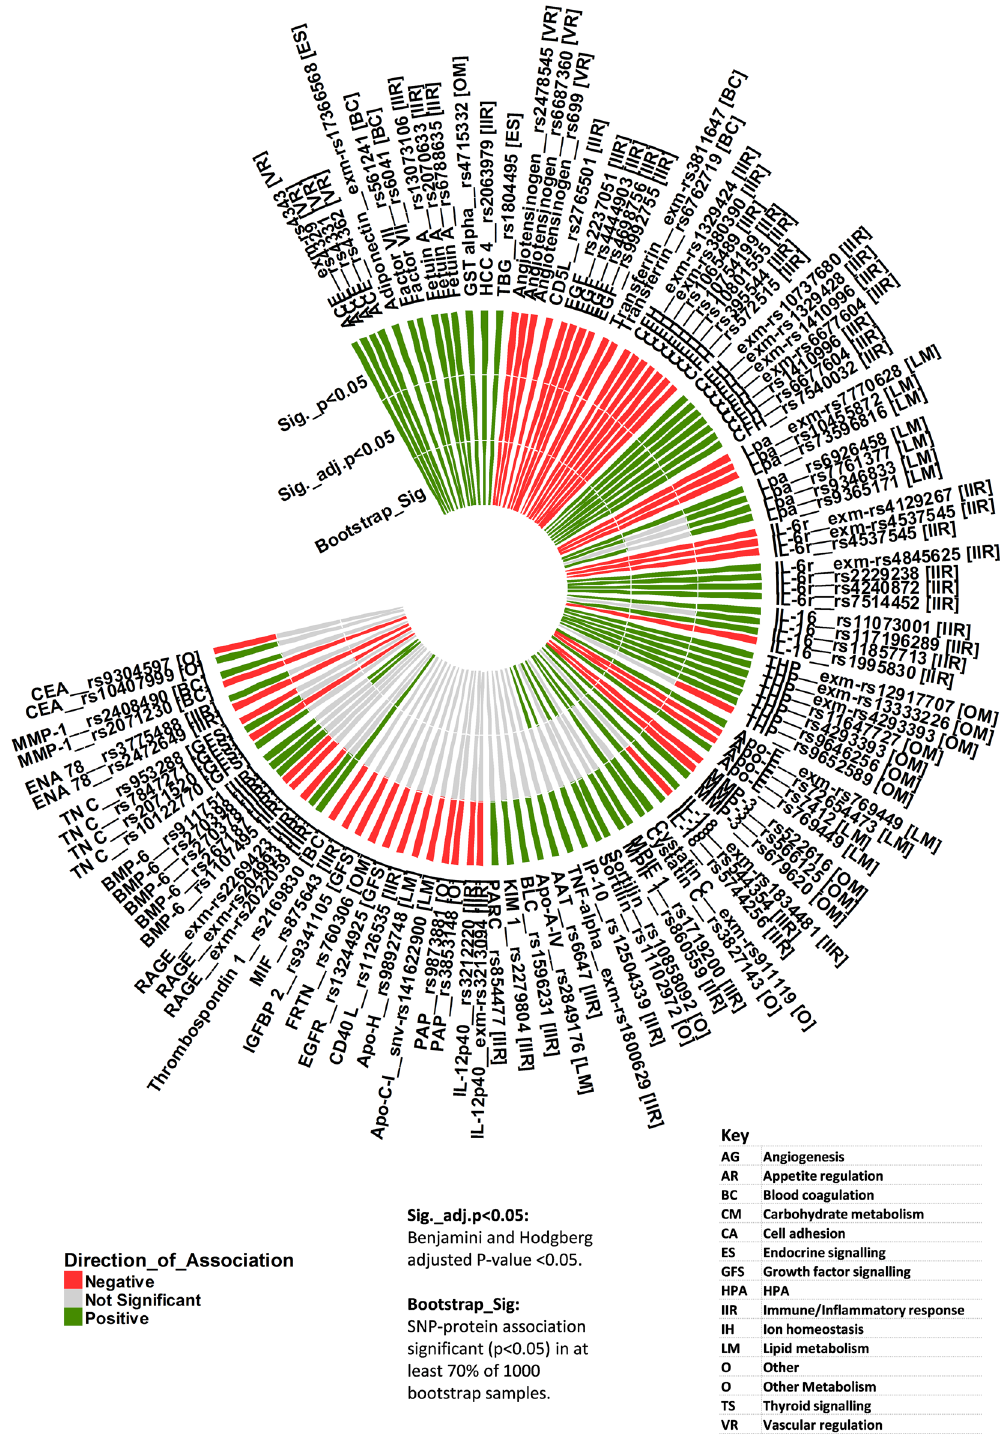
Figure 1. Polar histogram showing the significant SNP-protein associations. Key: A positive direction of association ( β ) indicates that a higher major allele copy number is associated with a higher protein level in blood. A negative direction of association ( −β ) indicates that a higher major allele copy number is associated with a lower protein level in